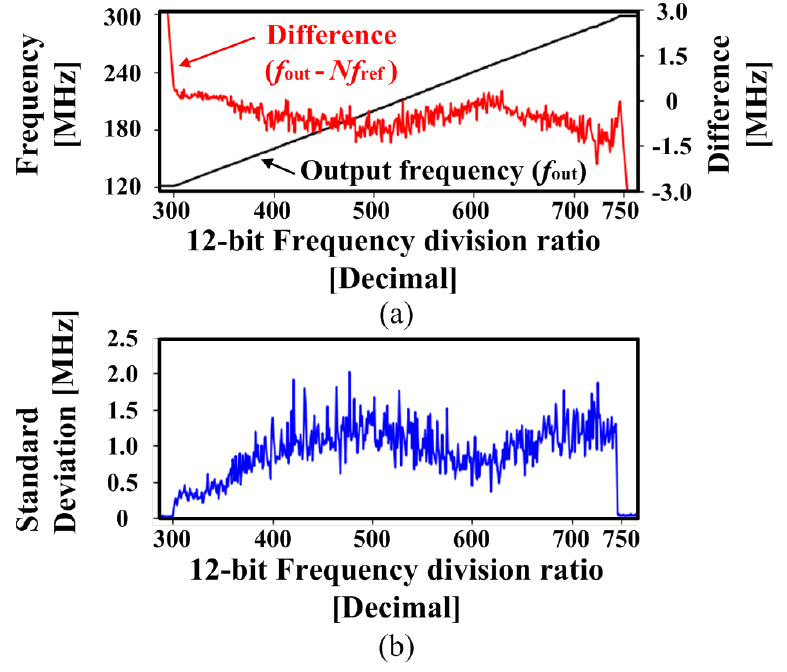
Figure 10. Measured ADPLL: ( a ) frequency division ratio tuning frequency range and difference from ideal value, and ( b ) standard